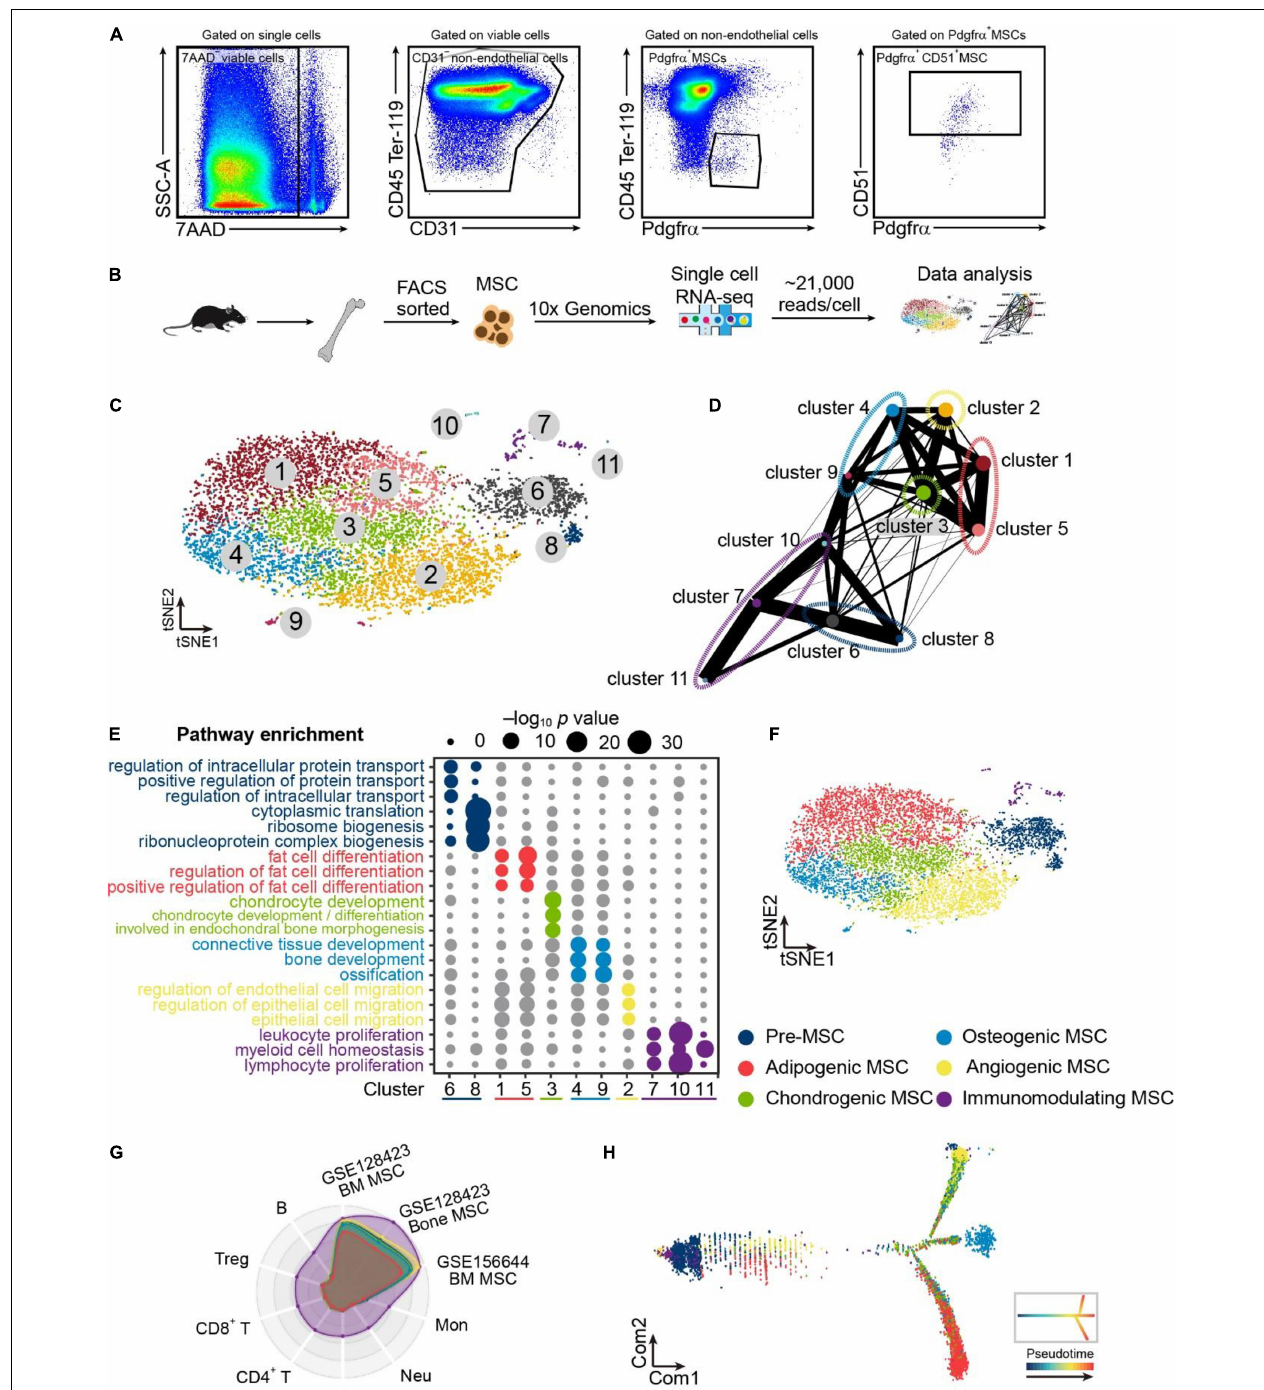
FIGURE 1 | Single-cell atlas identifies heterogeneous MSC populations. (A) Flow cytometry gating for isolating bone marrow MSCs. (B) Schematic depicting the strategy of cell isolation, MSC sorting, single-cell RNA sequencing, and data analysis. (C) Clustering 8883 cells from MSCs by tSNE. (D) Results of PAGA. Each node represents a cluster, and edges show the connectivity between clusters. The size of nodes indicates the number of cells in each cluster, and the thickness of the edges denotes the connectivity from low (thin) to high (thick). (E) Eleven clusters annotating by gene sets of GO terms based on their signatures and dividing into pre-, adipogenic, chondrogenic, osteogenic, angiogenic, and immunomodulating MSCs. (F) Clustering 8883 cells from bone marrow MSCs annotating six populations inferred from PAGA results and enriched pathways of marker genes. (G) Radar chart showing the spearman rho between the MSC scRNA-seq result in this study compared with the published MSC and immune cell scRNA-seq results. Each ring represents one population in (F) . (H) Developmental pseudotime of MSCs. The inset depicts the schema of pseudotime of MSCs.